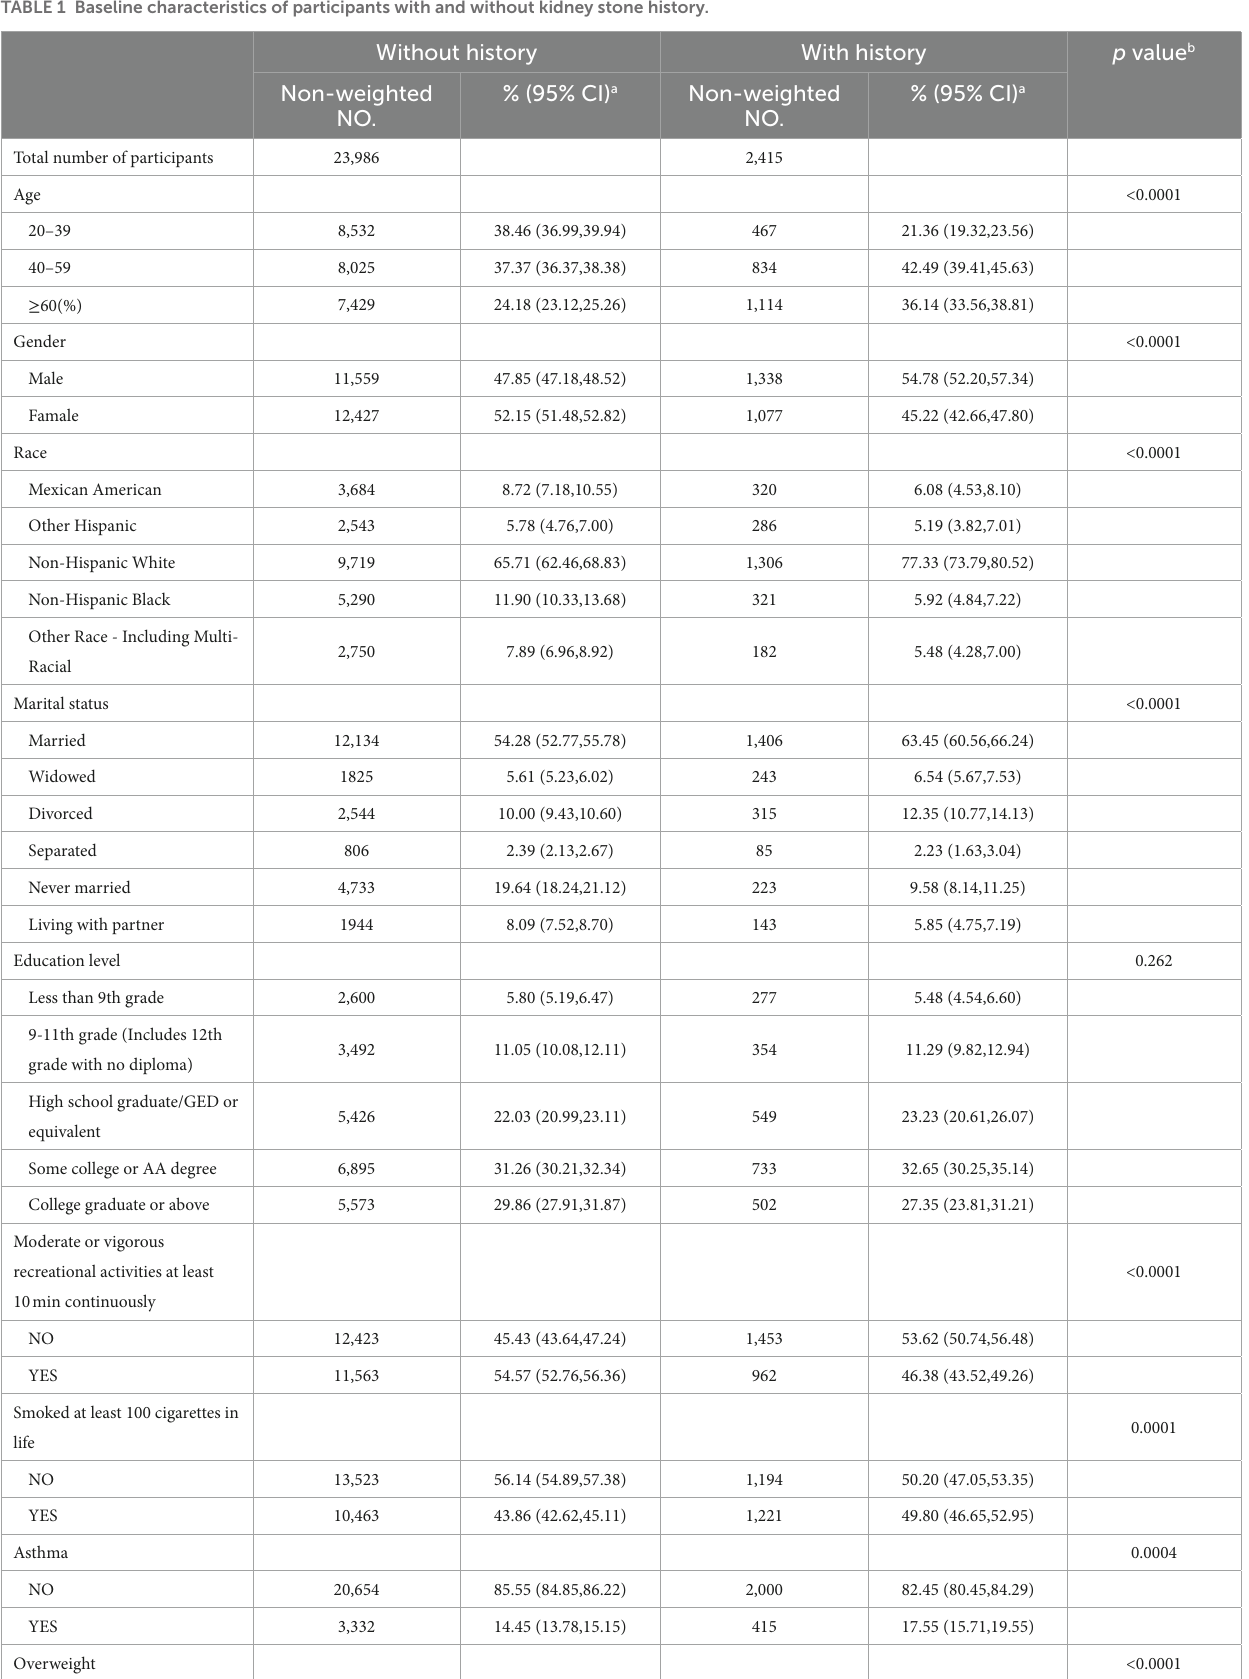
TABLE 1 Baseline characteristics of participants with and without kidney stone history. Without history With history p value b Non-weighted % (95% CI) a Non-weighted NO.